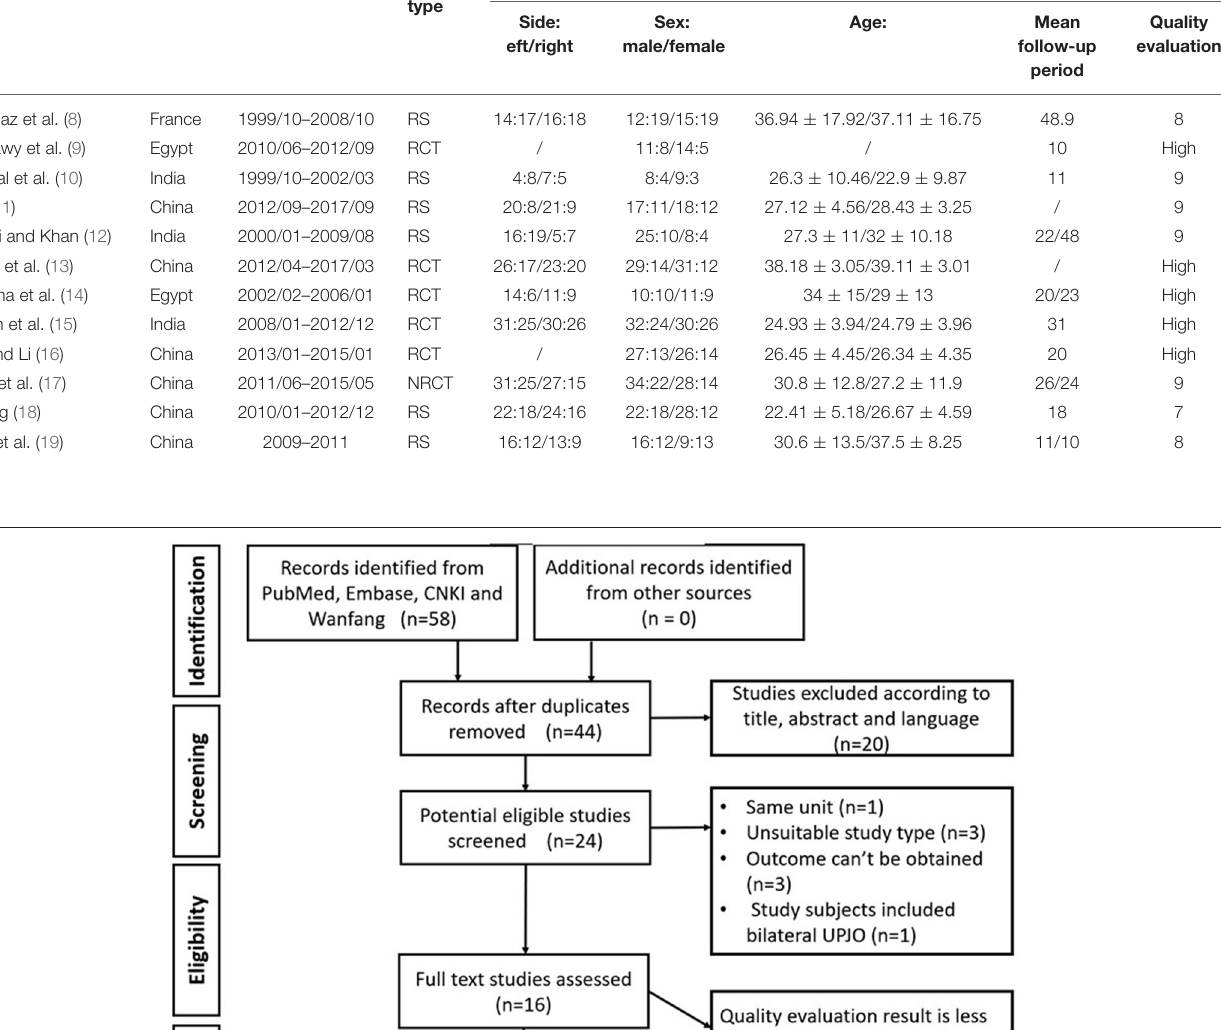
TABLE 1 | The basic characteristics of the included literature.